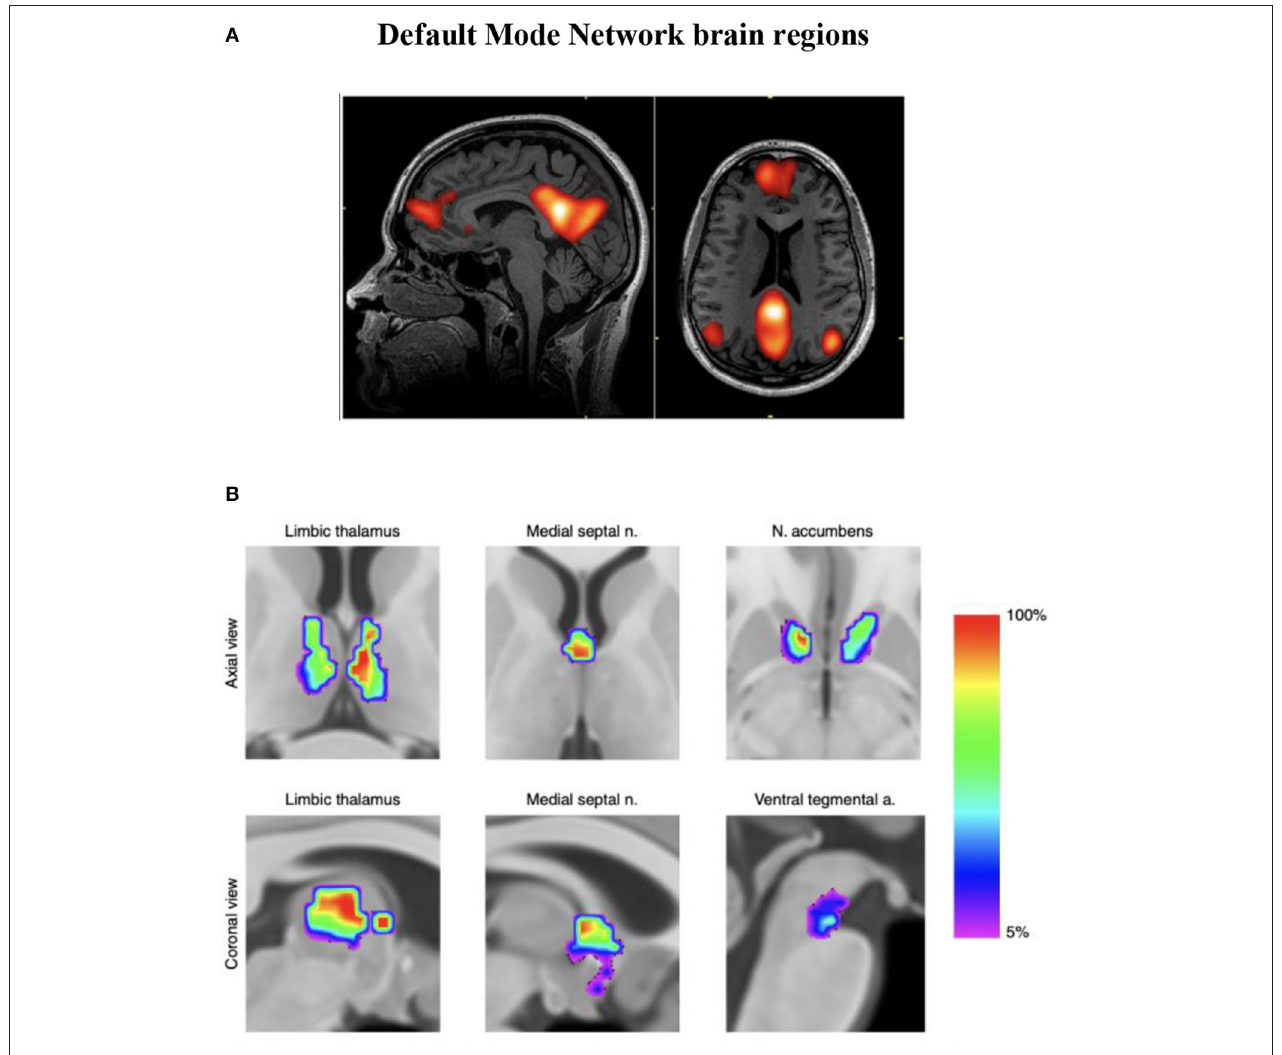
FIGURE 1 | (A) Functional MRI demonstration of the default mode network (DMN). (B) Discrete neuroanatomical model of the DMN showing coactivation of brainstem regions. This map is freely available at https://www.nature.com/articles/s42003-019-0611-3/figures/4. n = 20 participants. Improved neuroanatomical model of the default-mode network shows co-activation of brainstem and midbrain regions with DMN hubs. This reconciles previous neuroimaging and neuropathological findings (Alves et al.,